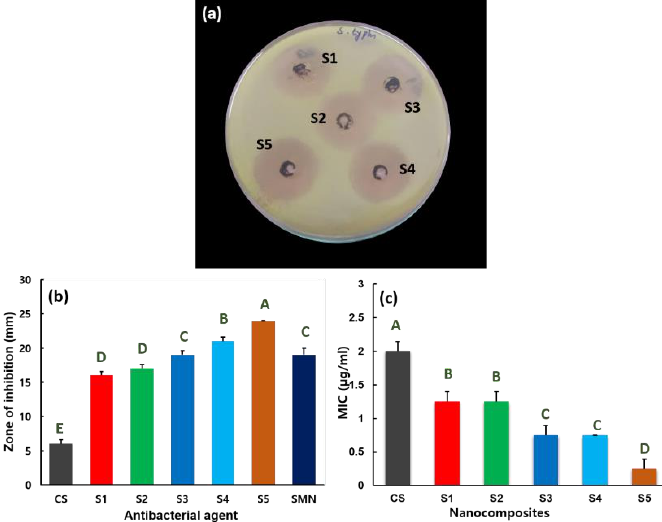
Figure 5. ( a ) Antibacterial activity of nanocomposites S1–S5 versus E. coli organism. ( b ) Zone of inhibition for CS, SMN, and nanocomposites S1–S5, stated as mean ± SD from the results of triplicate tests. Statistical analysis indicated that the values are significantly ( p ≤ 0.05) varied between their experiments which are indicated by capital letters. ( c ) MIC values for CS and nanocomposites S1–S5 versus E. coli , expressed as mean ± SD from the triplicate tests. Statistical analysis indicated that the values are significantly ( p ≤ 0.05) varied between their experiments, which are indicated by capital letters.